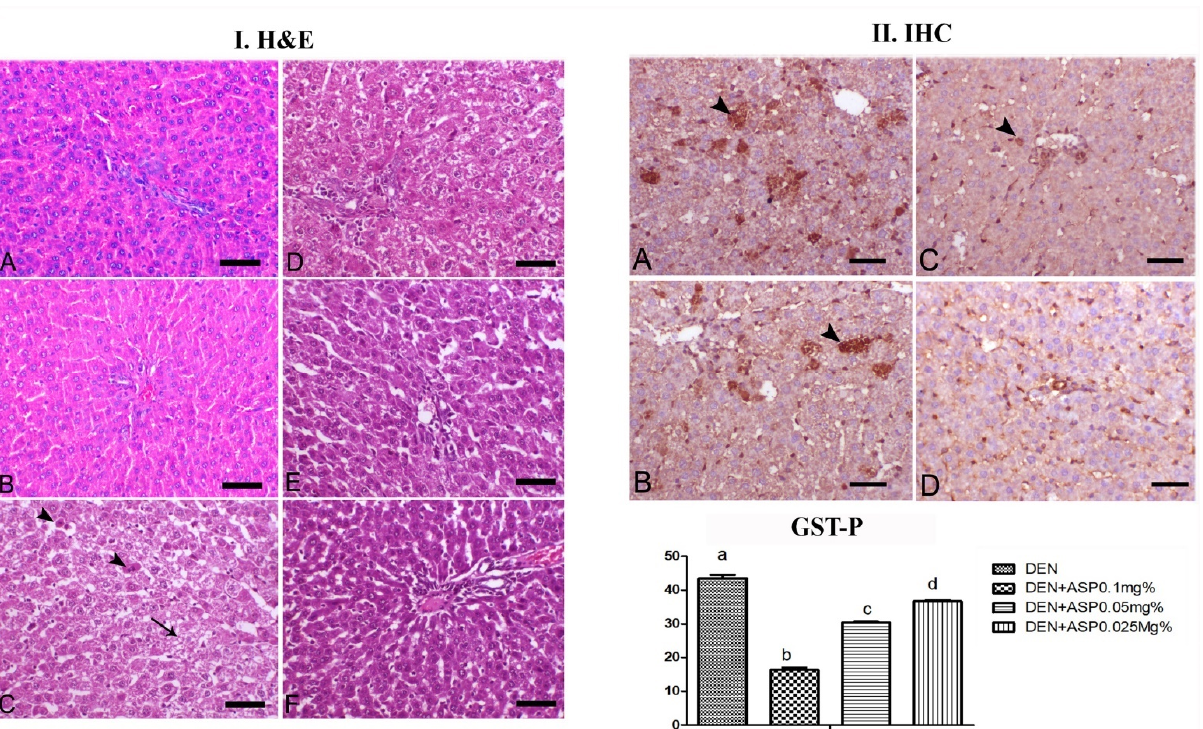
Figure 3. ( I ) Histopathological examinations of the liver in different experimental groups ( A , B ): Control untreated group showed normal liver structures; ( C ): DEN treated groups showed hepatocytes vacuolation (arrow) with an increase in mitosis (arrowheads). ( D – F ) : DEN + ASP1, DEN + ASP0.5, and DEN + ASP0.25, respectively, showed a moderate degree of hepatocyte vacuolation with a marked decrease in mitosis. H&E, bar= 50 μm. ( II ) Immunolabelling of glutathione S-transferase placental form (GST-P) in livers of rats in different experimental groups. ( A ): DEN group, ( B ) DEN/ASP1 group, ( C ), DEN/ASP0.5 group, ( D ), DEN/ASP0.25 group. Arrowheads point to GST-P positive foci (brown color). Scale bar= 50 μm. Values with different letters differ significantly at ( p ≤ 0.05). Table 5. Scoring summary of GST-P immunolabelling in different experimental groups in the liver tissues in a rat